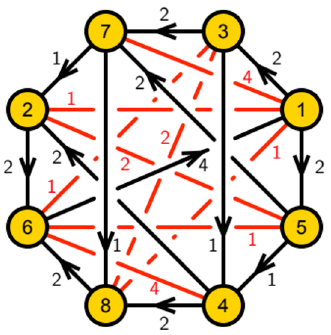
Figure 20 . Quiver for Model